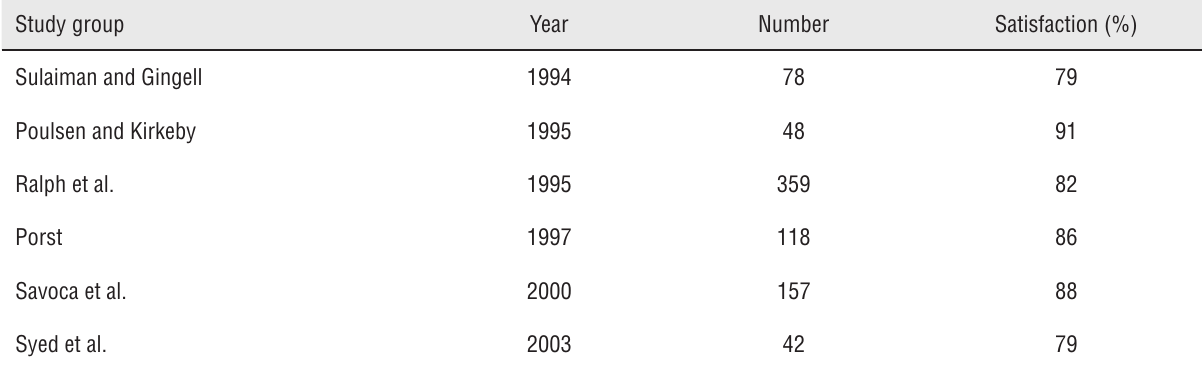
Table 1 - Results of the Nesbit Operation for Peyronie’s Disease (14). Study group